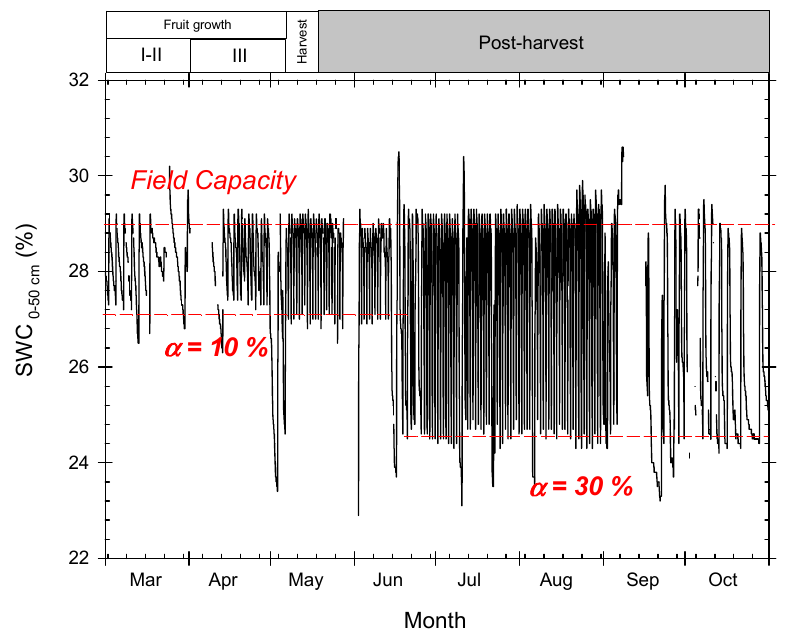
Figure 1. Average soil water content (SWC, %) during the irrigation season at the 0–50 cm layer of the soil profile. Dashed horizontal lines delimit field capacity and the allowed plant water deficit ( α ) imposed threshold values: 10% (fruit growth and early post-harvest) and 30% (late post-harvest) of field capacity, respectively. Phenological stages for nectarine trees are depicted in the top box.